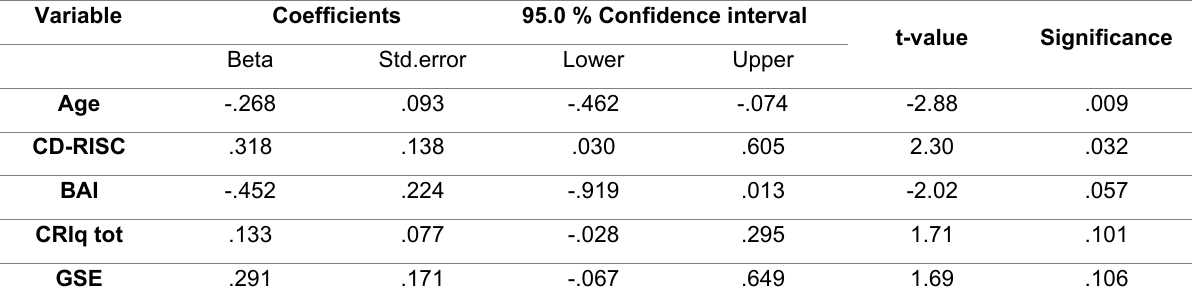
Table 4 Linear Regression Analysis for Familiarity of Technology